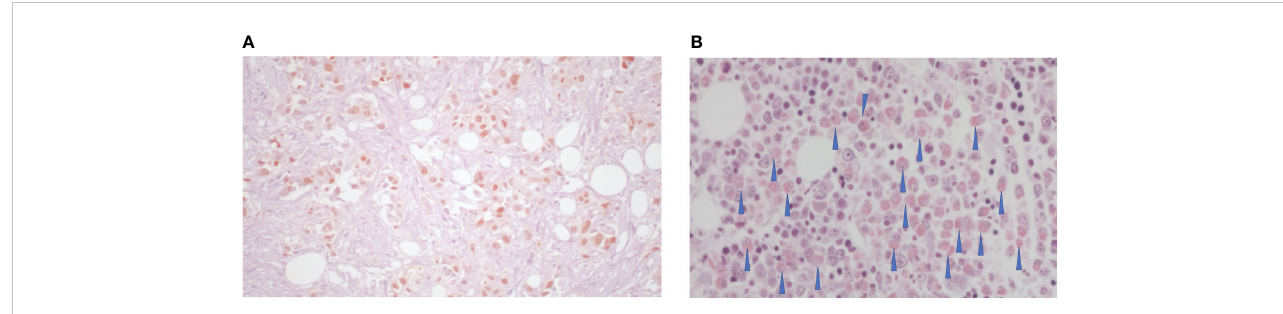
FIGURE 3 (A) Hematoxylin and eosin staining of adenocarcinoma of the lung, TTF1+ associated with fi brosis (70%); (B) Giemsa eosinophilic in fi ltrate, as indicated by the arrows.